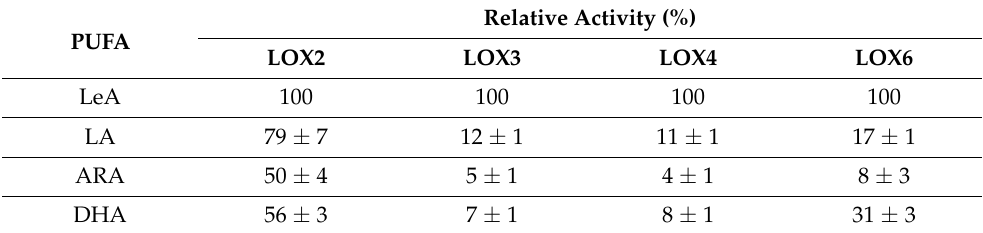
Table 1. Substrate specificities of LOX2, LOX3, LOX4 and LOX6.